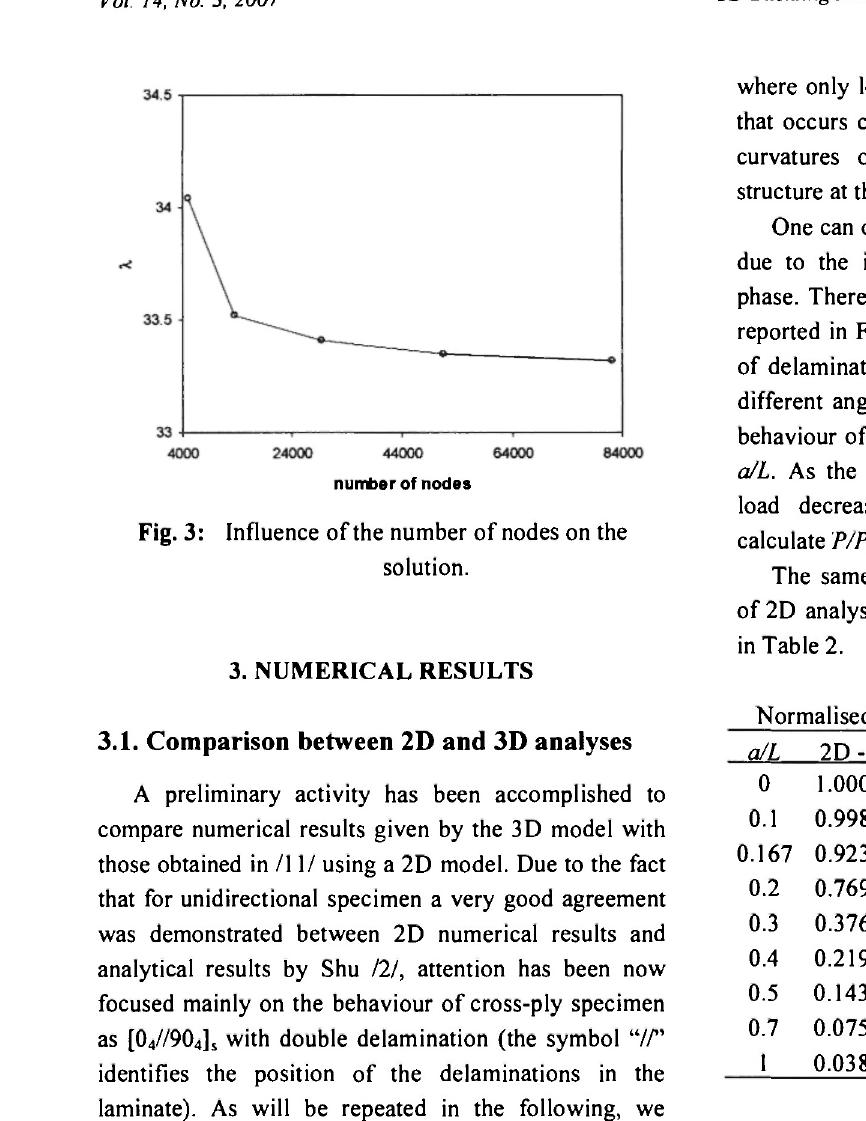
Normalised buckling load for the [0 4 //90 4 ] s laminate.